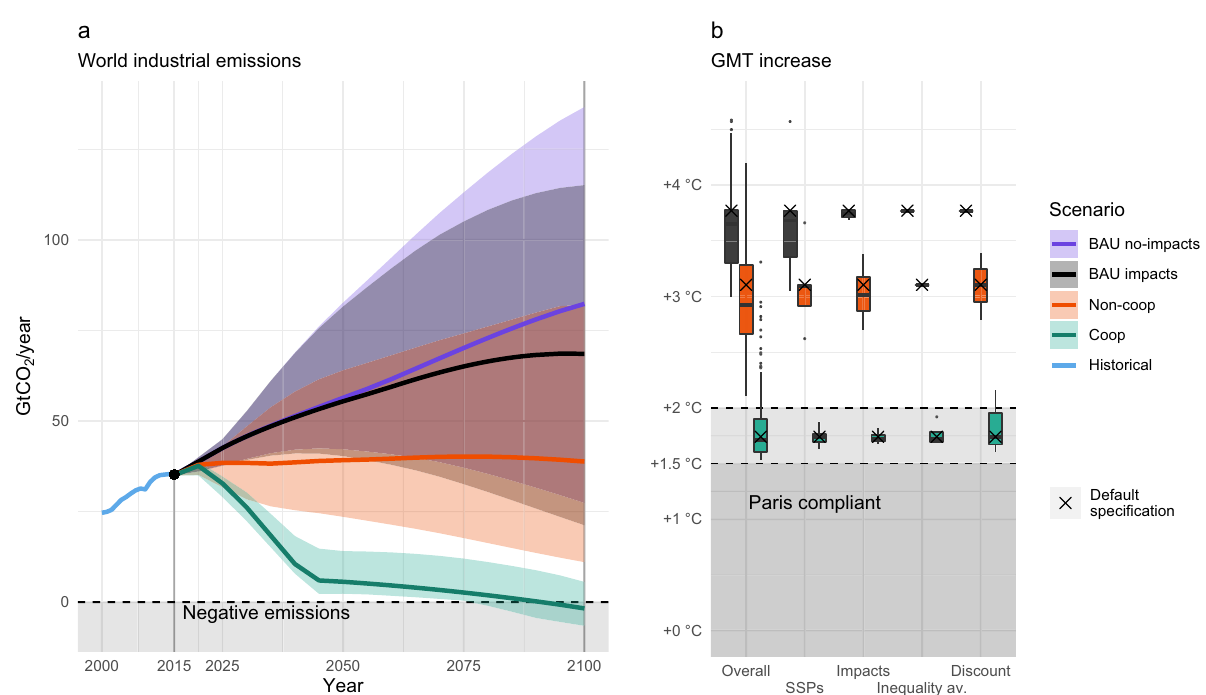
Fig. 1 Optimal world-aggregated model outcomes. a Global CO 2 emissions pathways. Uncertainty ranges include all SSPs and climate change impacts. b Global Mean Temperature (GMT) increase in 2100, and decomposed uncertainties ranges. Overall accounts for all the uncertainties. Other factors show temperature variability due to every single driver (with others fi xed at their default level). Default speci fi cation (SSP2, BHM-SR impacts, utility discount rate of 1.5% and γ = 0.5) values are highlighted with a cross